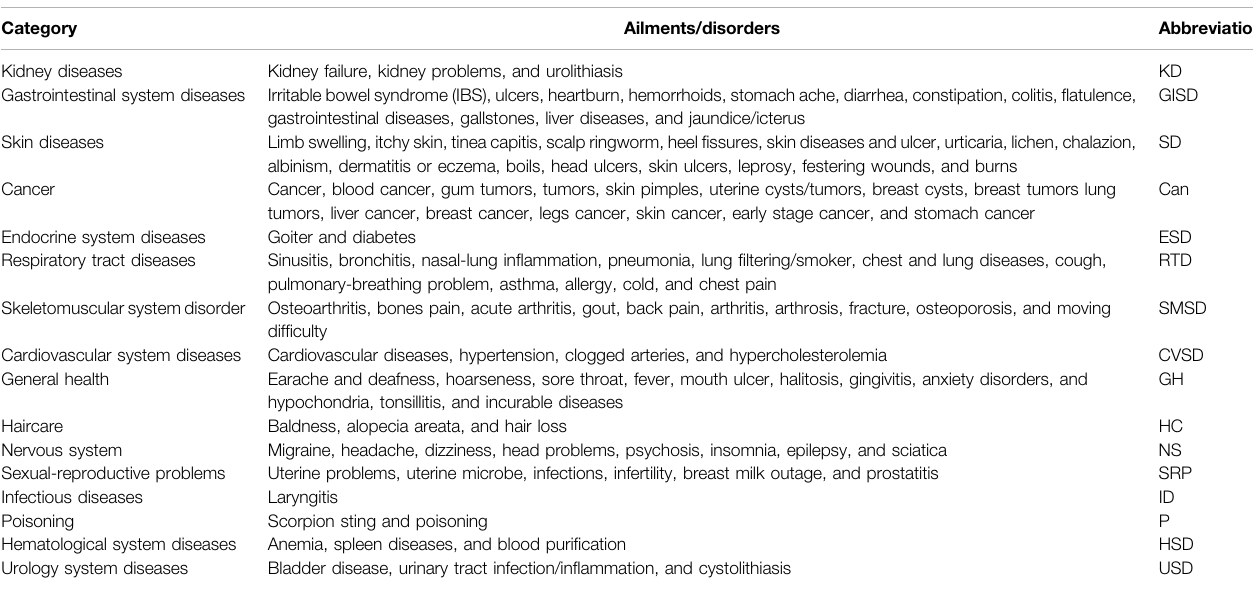
TABLE 2 | Ailments